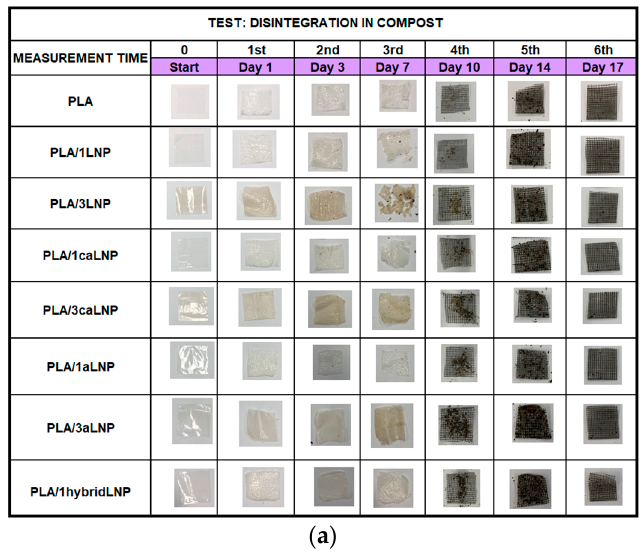
Table 4. Overall migration values in Simulants A and D1 ( 10% ( v / v ) and 50% ( v / v ) ethanol, respectively) for PLA and PLA nanocomposite films.